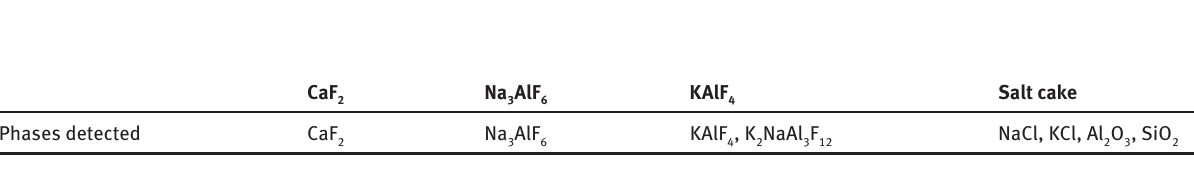
Table 1: Chemical analysis (by ICP-OES, mass%) of metals in each of the slag fluidisers. Metal contents were calculated as either fluoride, chlorides, or oxides, as noted.